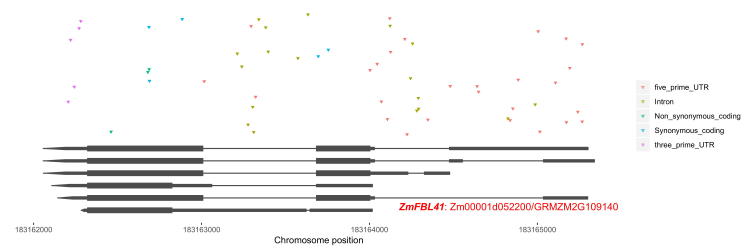
SNPs located within the genic region of ZmFBL41 demonstrated by the genome browser functionality of MaizeSNPDB. Structure of six annotated mRNAs of ZmFBL41 are displayed at the bottom of the main plot region. X-aixs, coordinates of the genomic region.